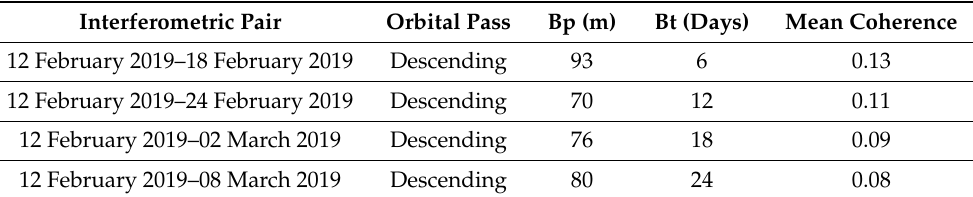
Figure 6. Coherence histograms for selected Sentinel-1 SLC image pairs (Table 3). Arrows indicate the mean coherence value. Table 3. Parameters of image pairs selected for interferometric coherence analysis. Bp is the perpen- dicular baseline; Bt is the temporal